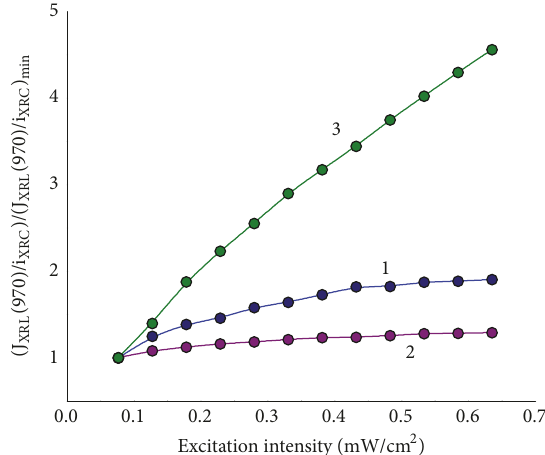
Figure 10: Normalized dependencies of the ratio of the intensity of the XRL 970 nm band to the X-ray conductivity current on the excitation intensity at temperatures: 8 K (1) , 85 K (2) , and 295 K (3) .